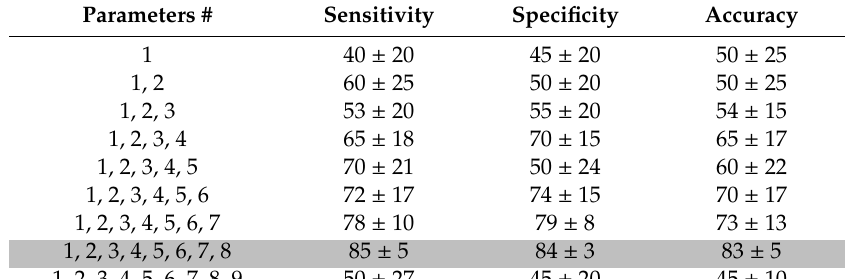
Table 4. Five-fold classification results using k-nearest neighbor (KNN) .